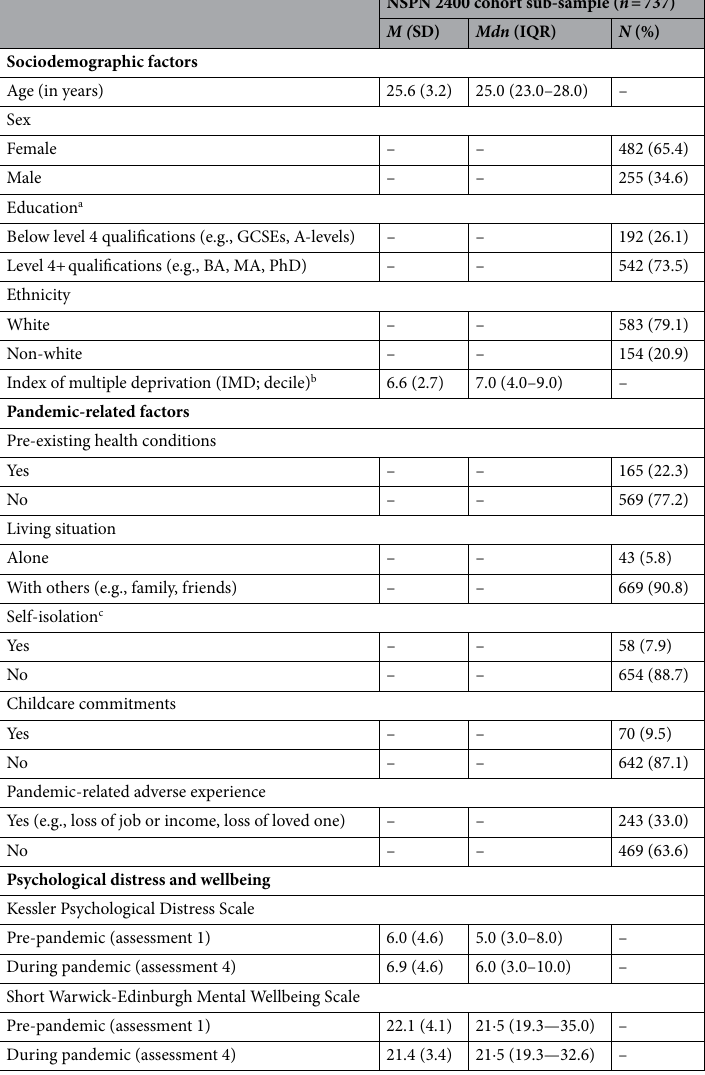
Pre-existing health conditions (reported during the pandemic) were associated with higher observed K6 scores ( b [unstd] = 3.11, SE = 0.42, 95% CI [2.28, 3.95], p adj < 0.001) and higher extended residuals, reflecting higher- than-expected psychological distress ( b [unstd] = 1.69, SE = 0.56, 95% CI [0.59, 2.80], p adj = 0.04). Nonetheless, the explanatory power (proportion of the variance explained) in either model was low (R 2 = 0.12, F(5,617) = 18.26 , p < 0.001 for observed K6 scores and R 2 = 0.02, F(5,617) = 3.42 , p < 0.01 for corresponding extended residuals). Pre-existing health conditions within this cohort were predominately clinically diagnosed mental health rather than physical conditions. For a detailed breakdown, see Supplementary Materials 4c. None of the sociodemographic risk factors were a statistically significant predictor of mental wellbe- ing (SWEMWBS) in linear regression models. Two pandemic-related risk factors significantly predicted observed mental wellbeing scores, i.e., participants with pre-existing health conditions and those who reported